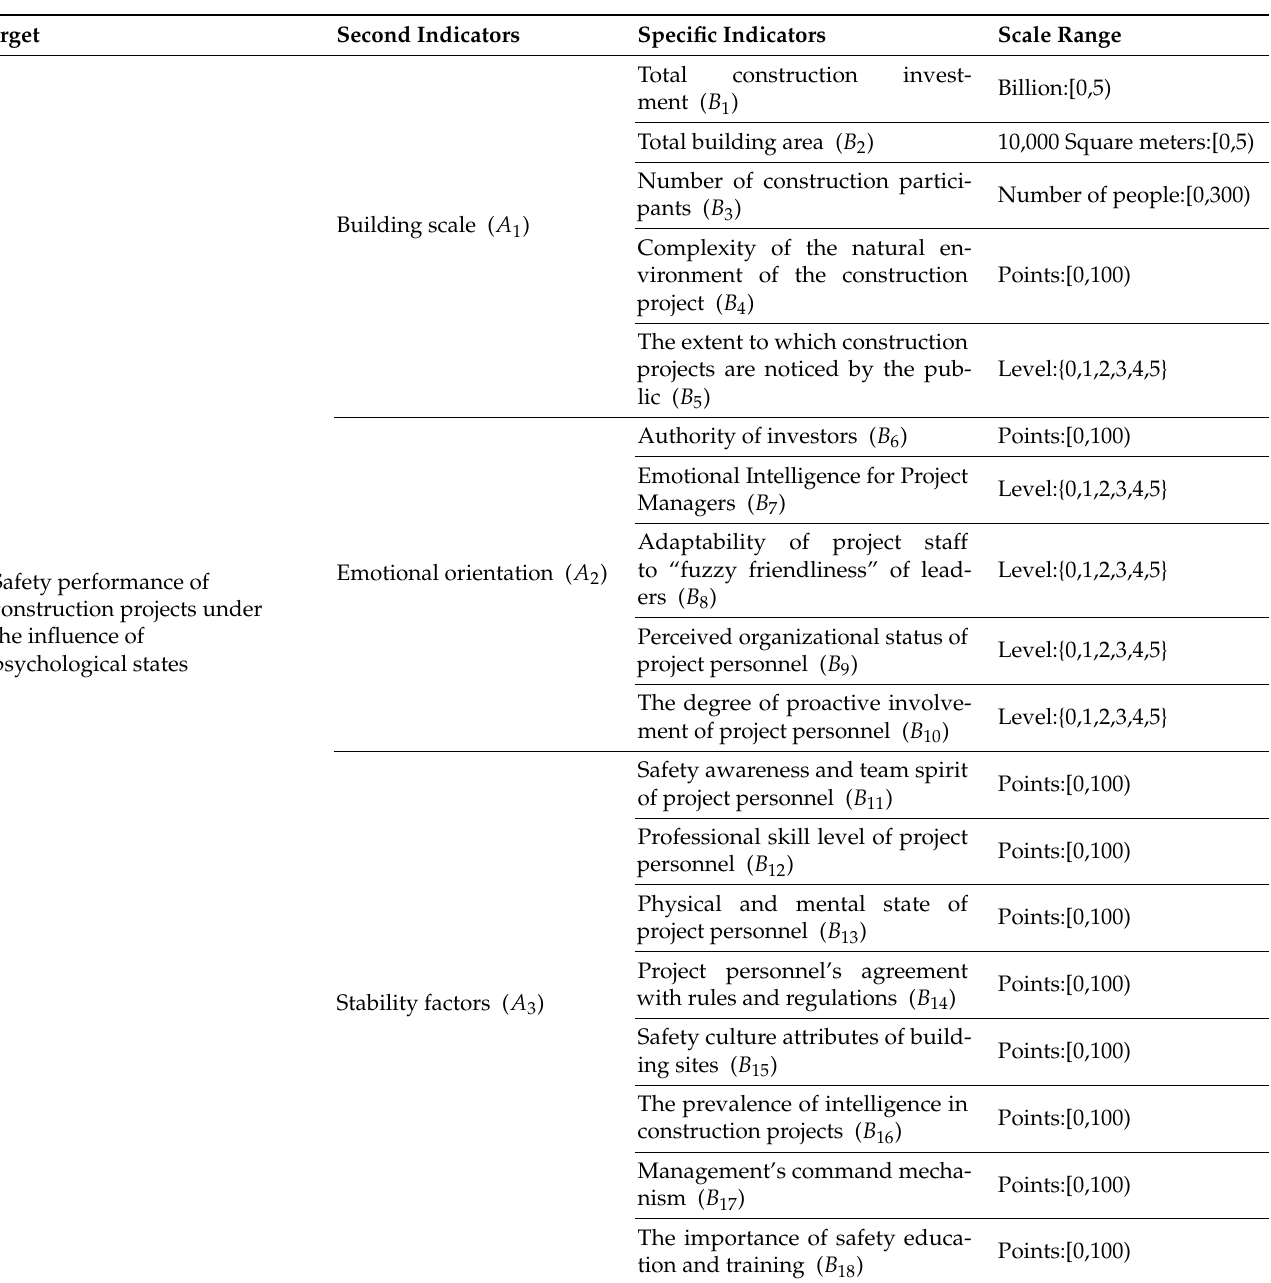
Table 2. Indicator system for the safety performances of construction projects under the influence of psychological